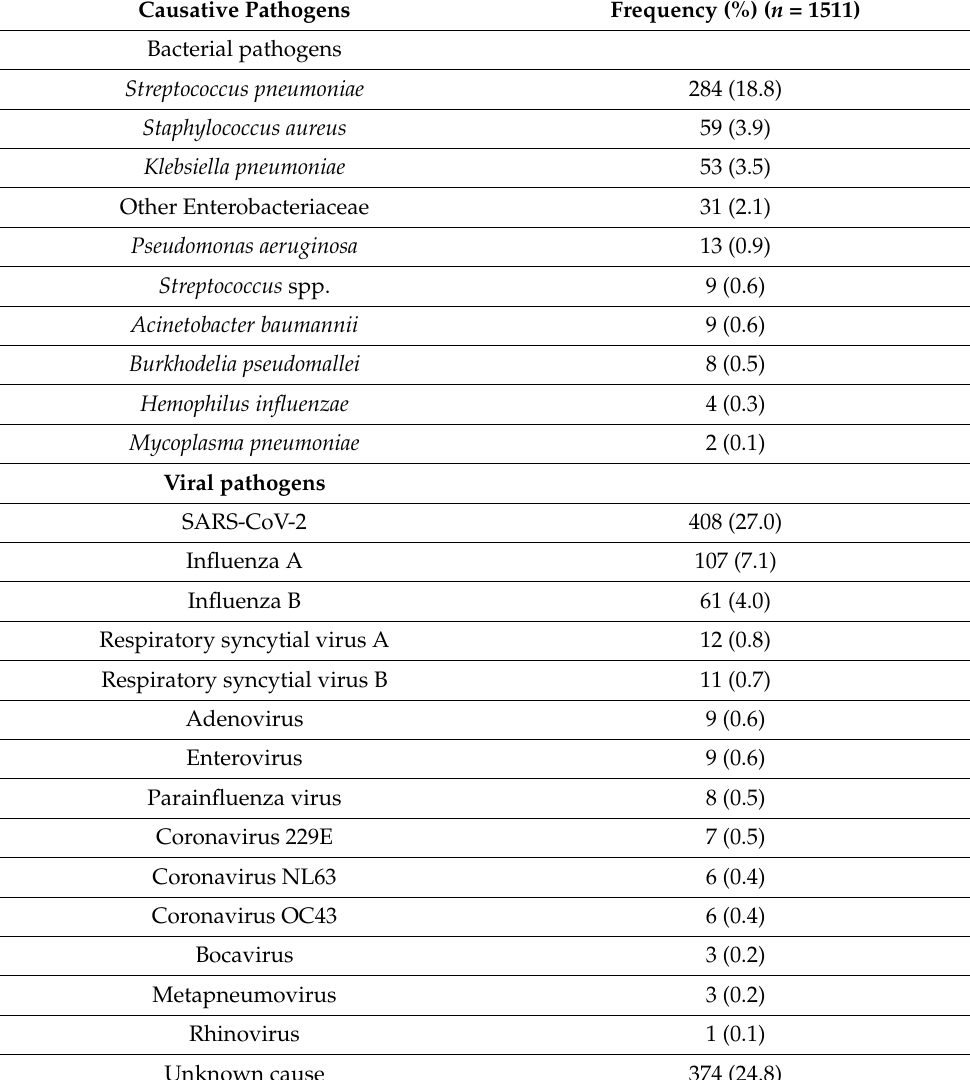
Table 1. Causative pathogens of community-acquired pneumonia (CAP) in the study